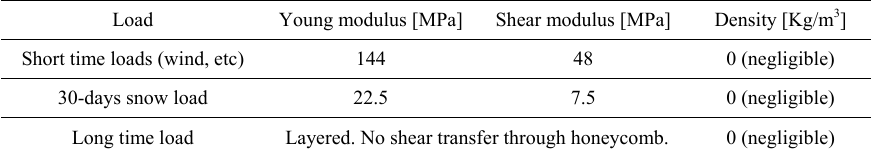
Table 1: Equivalent linear isotropic properties of 25x25 mm honeycomb bonded on two glass